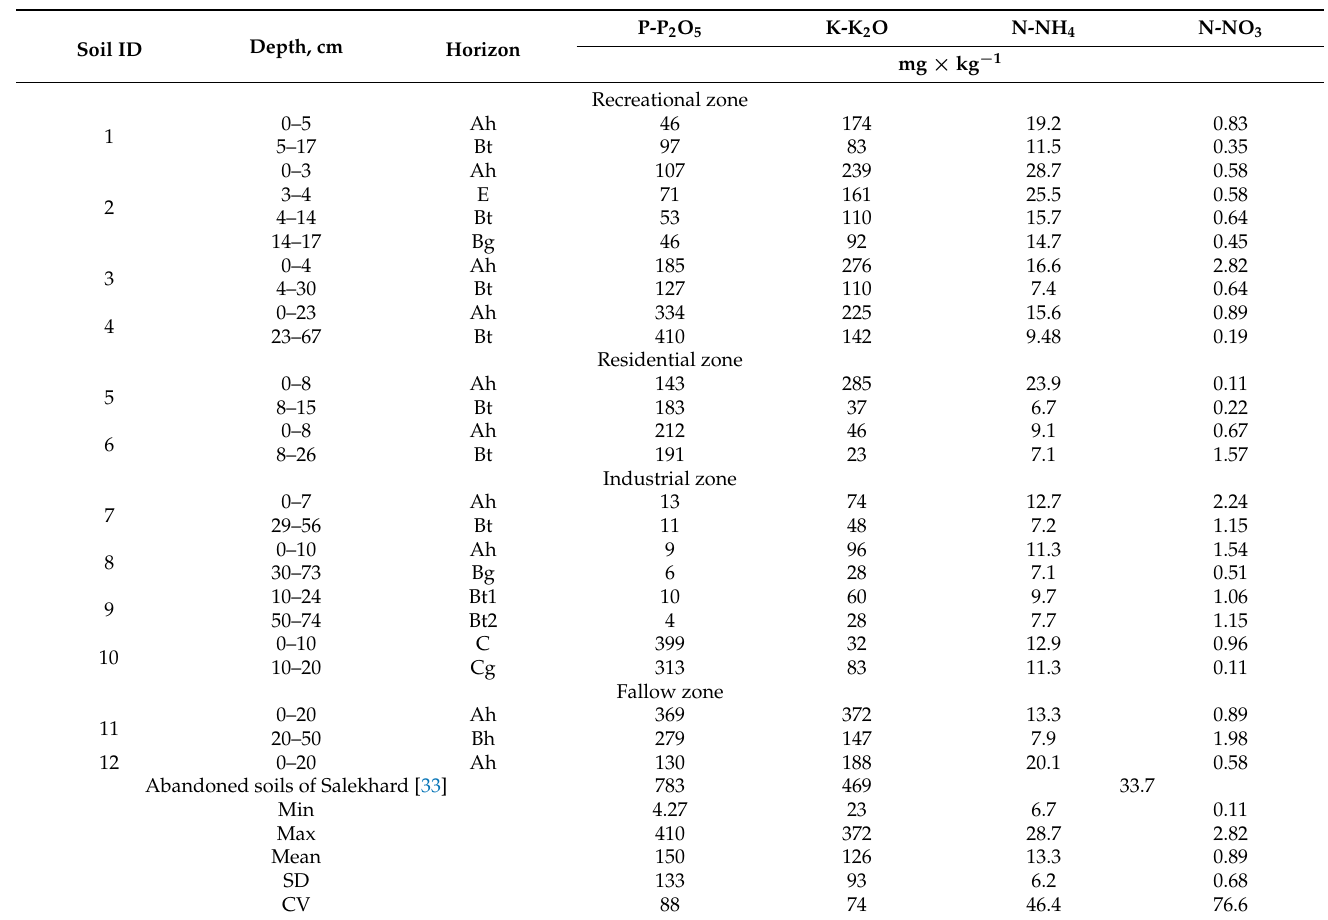
Table 4. The agrochemical parameters of study soils in Yakutsk city. The soil ID correspond to Table 1. SD-standard deviation; CV-coefficient